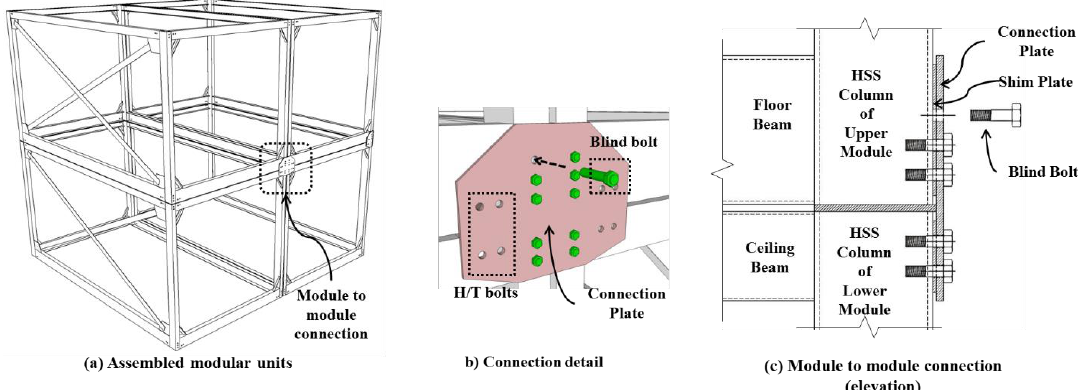
Figure 2. Module-to-module connection